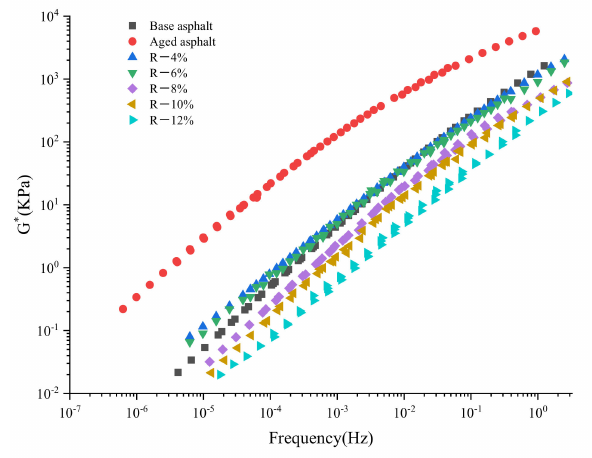
Figure 4. Master curve of complex modulus of reclaimed asphalt.